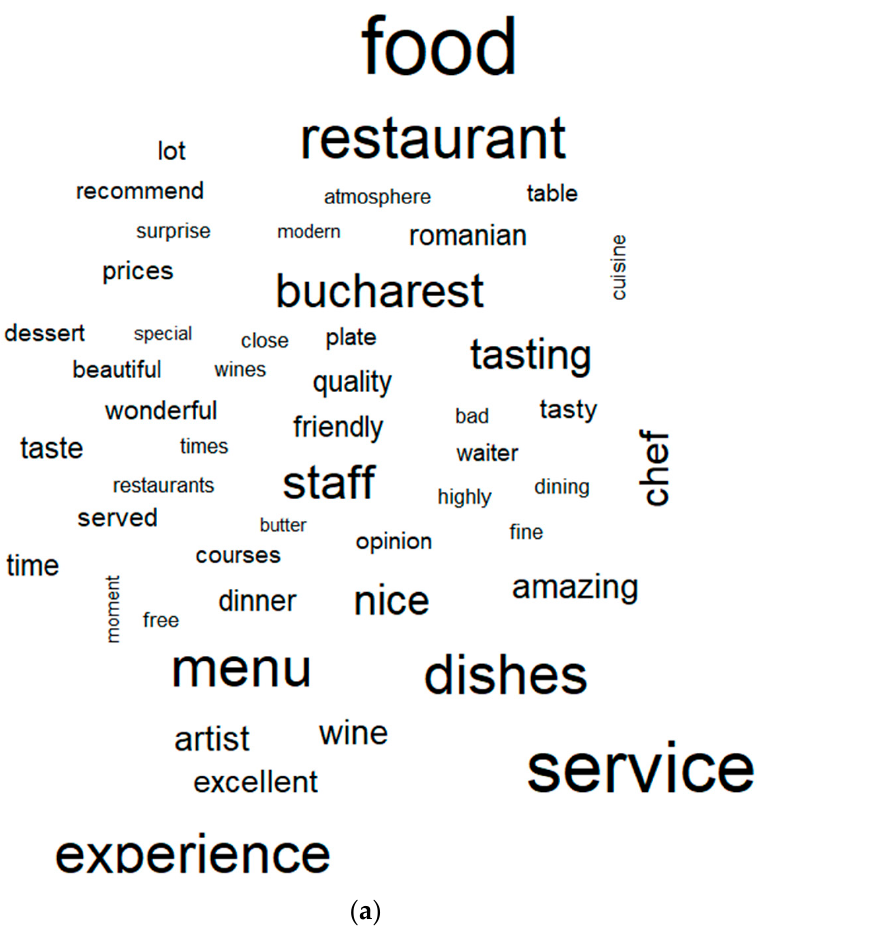
Figure 2. Word cloud analysis for all restaurants before and during the pandemic: ( a ) before the pandemic; ( b ) during the pandemic.